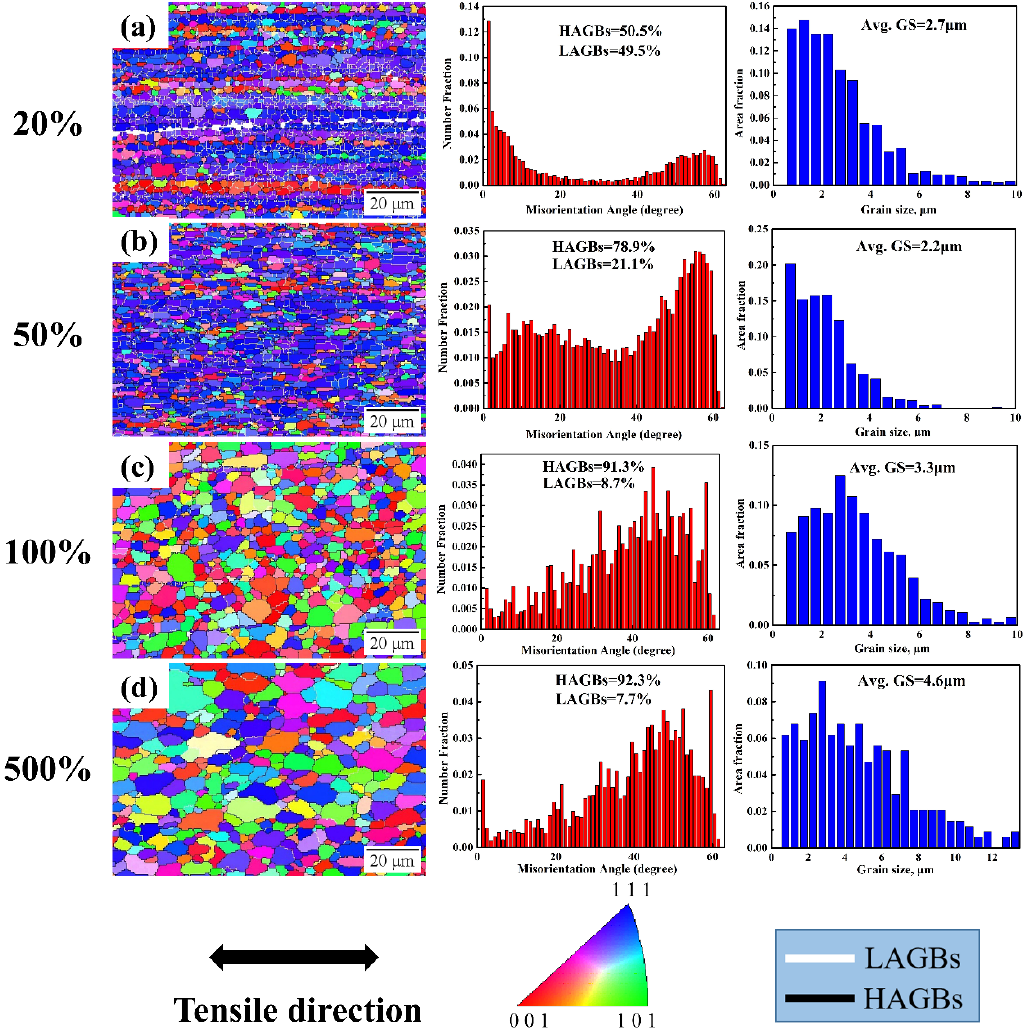
Figure 10. IPF maps of the gauge section microstructure tested at 1 × 10 −3 s −1 and 500 °C with different engineering strains of ( a ) 20%, ( b ) 50%, ( c ) 100% and ( d ) 500%. Here, the misorientation angle histograms and grain size histograms corresponding to different engineering strains of 20%, 50%, 100% and 500% are shown at the right side.